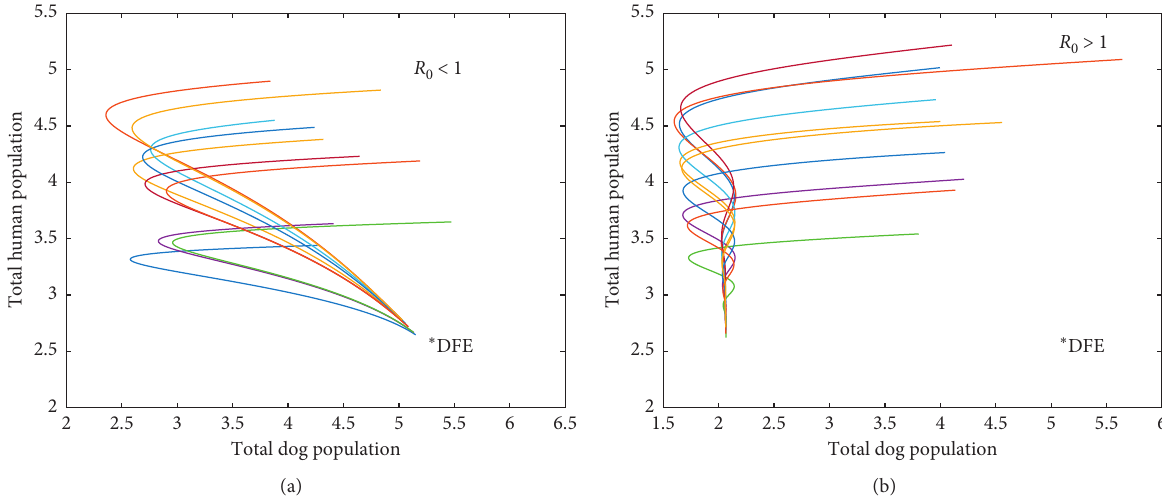
Figure 2: Simulation of model (1) showing the local asymptotic stability of the E